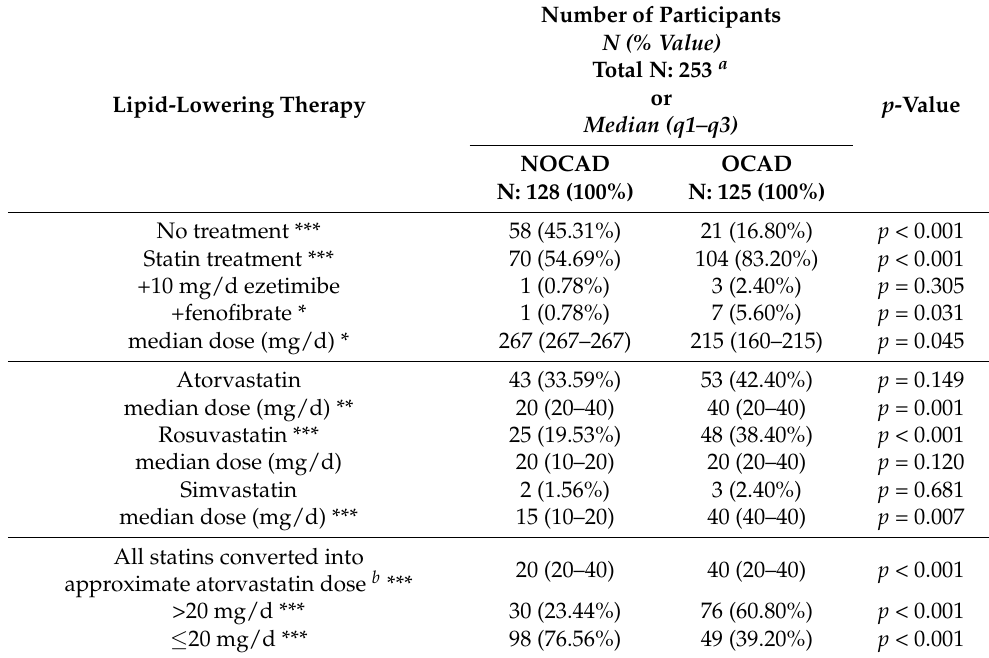
Table 5. Pre-hospital lipid-lowering